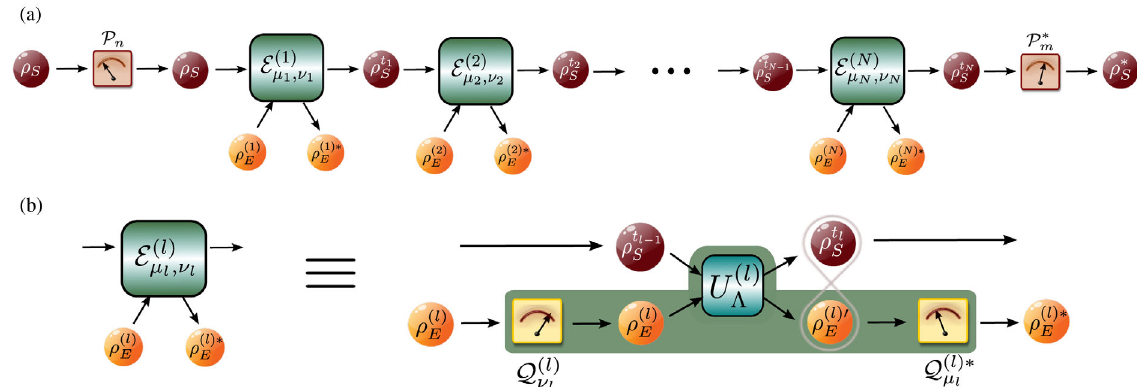
FIG. 2. (a) Schematic diagram of a trajectory generated by the map concatenation. Projective measurements on the system are only performed at the beginning and at the end of the concatenation. (b) Any operation E ð l Þ μ the system with an environmental ancilla in the state ρ ð l Þ before and after interaction, generating outcomes ν